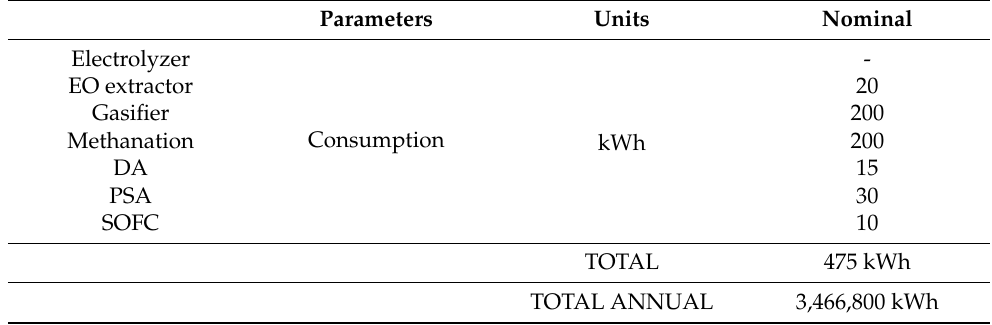
Table 10. Annual consumption in kWh of the units that make up the proposed biorefinery